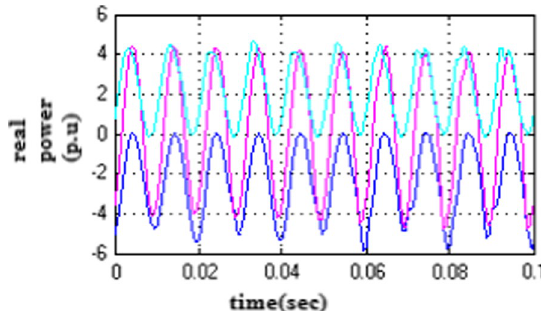
Fig. 24 Real power flow at bus 16 without STATCOM of IEEE 57- bus